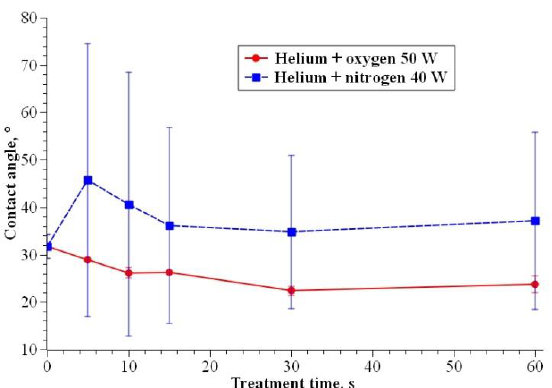
Figure 23. Contact angle versus treatment time for rapeseed oil (90 g / m 2 ) measured 1 s after a droplet contact with the paper surface, at 3 cm distance between the paper surface and a nozzle of the APPJ [71,73].